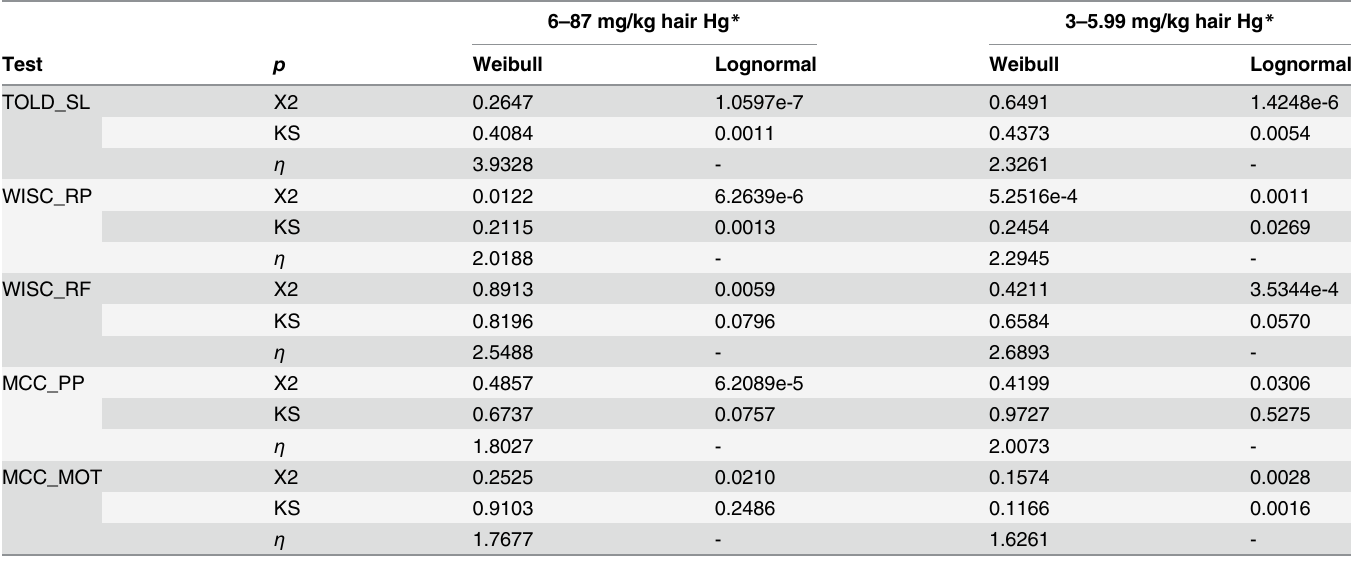
Table 2. Fits of the Data of Kjellström et al. on Test Scores of Children with Prenatal Mercury Exposure to the Weibull and Lognormal